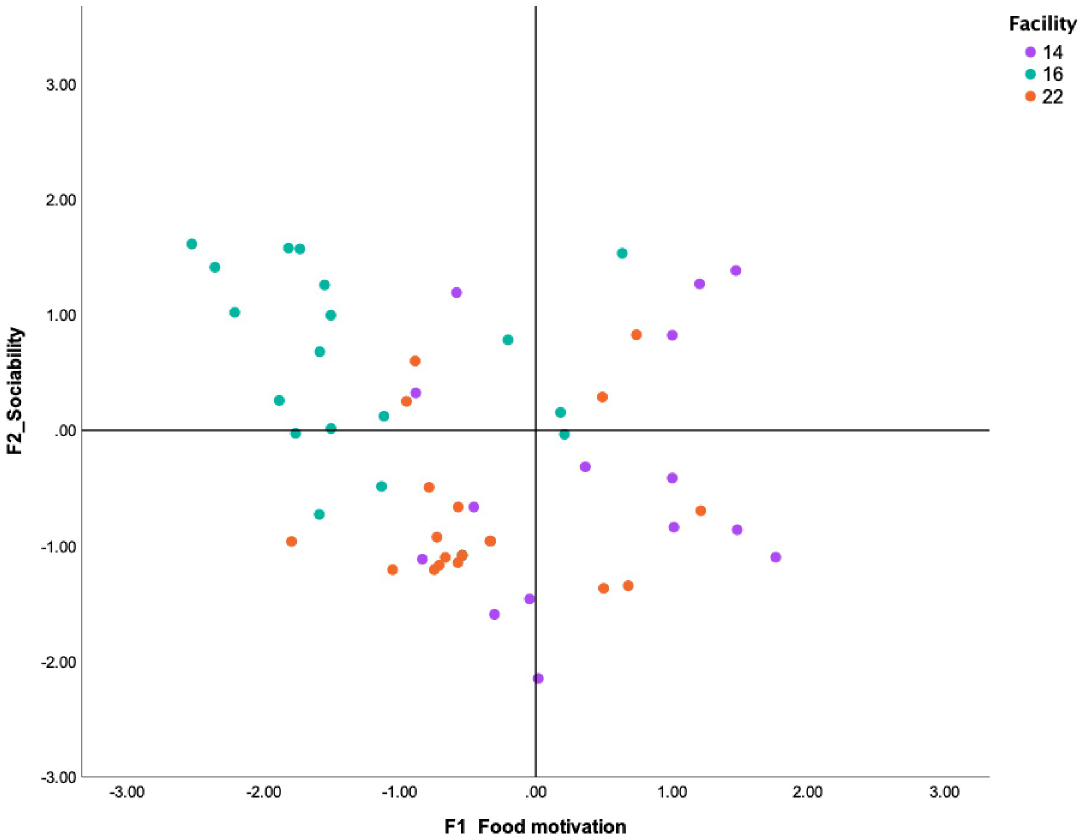
Fig 4. Example plot 2. Standardized factor scores (generated by the EFA) for each of the dogs tested in three of our facilities are plotted against two of the main behavioral factor scores extracted by the EFA: Food Motivation (F1) and Sociability (F2). Higher values on the X-axis represent higher propensity to take the treats offered during the test; higher values on the Y-axis represent scores for more engaging and affiliative behaviors towards the experimenter.